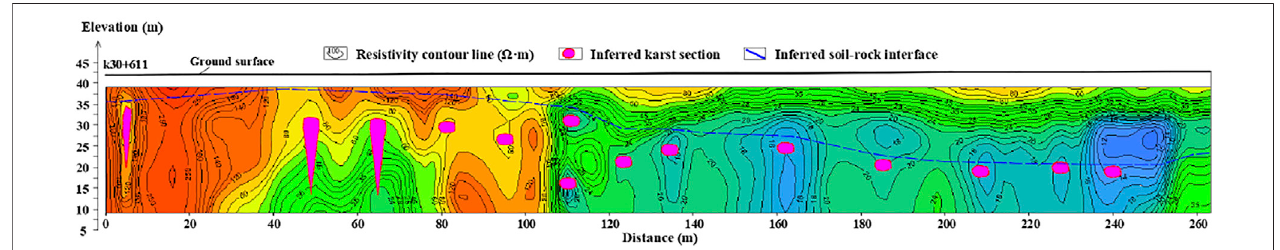
FIGURE 8 | Ahead detection results of the karst caves.